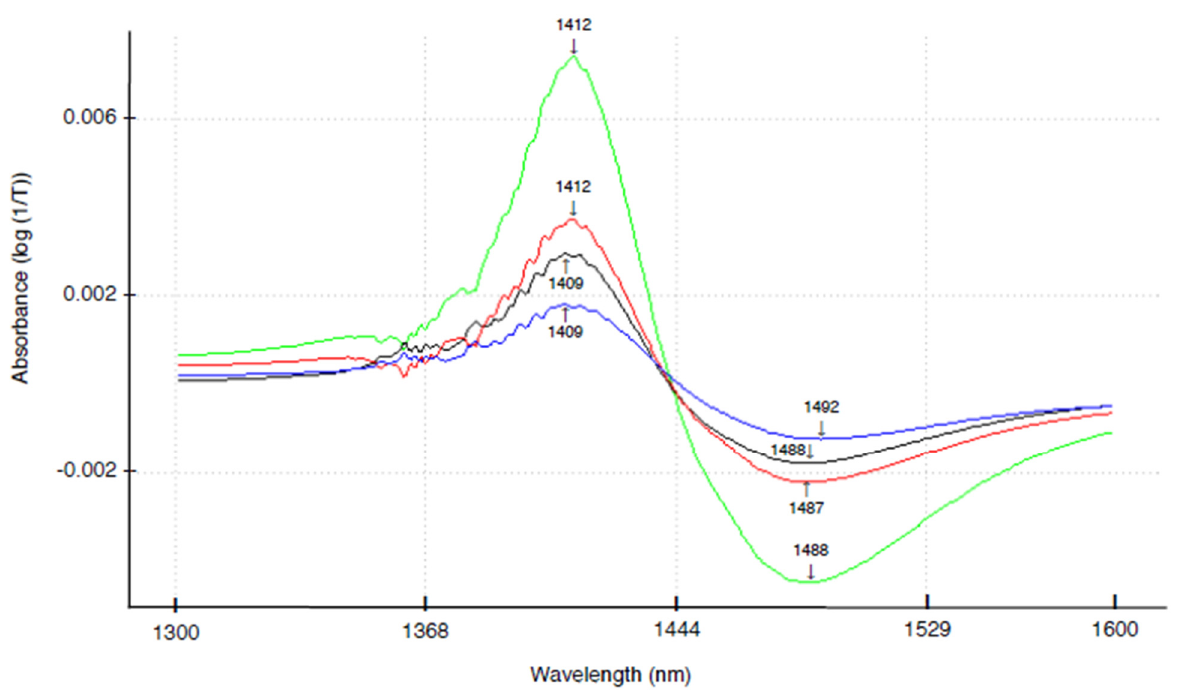
Figure 3. Difference spectra indicate the regions of largest spectral difference during temperature perturbation between: Aged water (Cha2014) and freshly produced water (Cha2016)—green line, low ion content waters (Q, PQ, Cha, Cha2014/2016, and Gan) and high mineral content waters (Tib, Kun, and Tap)—red line, low pH waters ( p < 7.5) and high pH waters ( ≥ 7.5)—black line, and processed water (PQ, Ch2014 and Cha2016) and non-processed water (Q and Cha)—blue line.